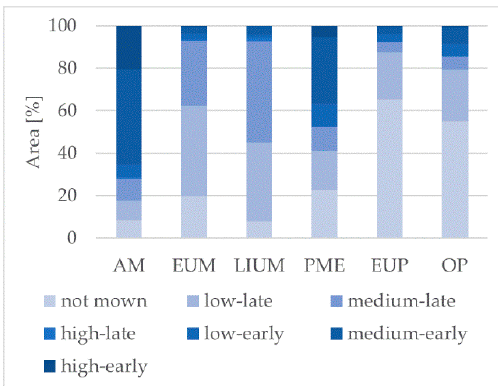
Figure 9. Percentage of grassland parcel area derived from various spatial mapping units and clouds masking levels within GMI categories, and number of detected mowing events: mean and maximum (frequency). Optimized-pixel—aggregated to parcel (OPxP); Optimized-pixel—aggregated to shrunken parcel (OPxSP).